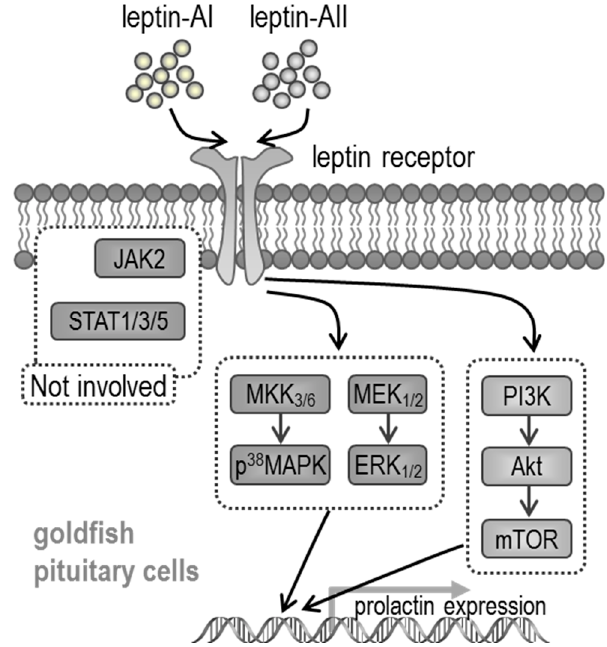
Figure 6 . Working model for signal transduction mechanisms involved in leptin stimulation of PRL gene expression via lepR in the goldfish pituitary.